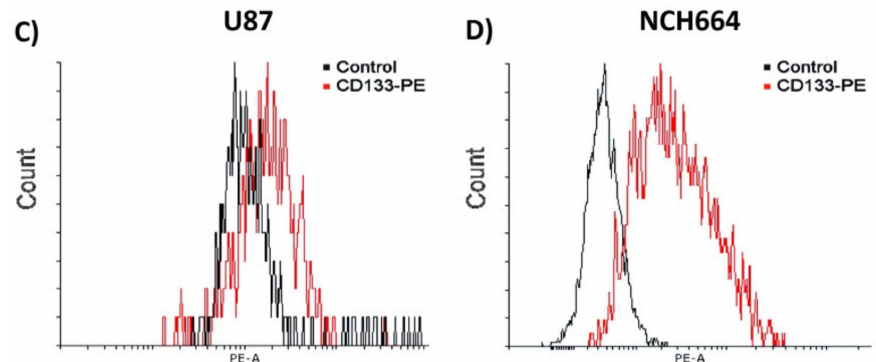
Figure 7. Analysis of the amount of CD133 expression on glioblastoma cancer cells by FACS. Depicted are histograms of exemplary measurements of cells stained with CD133/AC133-PE. The cells have displayed different ratios of CD133 expression ( A ) LN229 = 33.8%, ( B ) GBM1= 33.1% ( C ) U87 = 21.5% and ( D ) NCH664 = 89.2%.